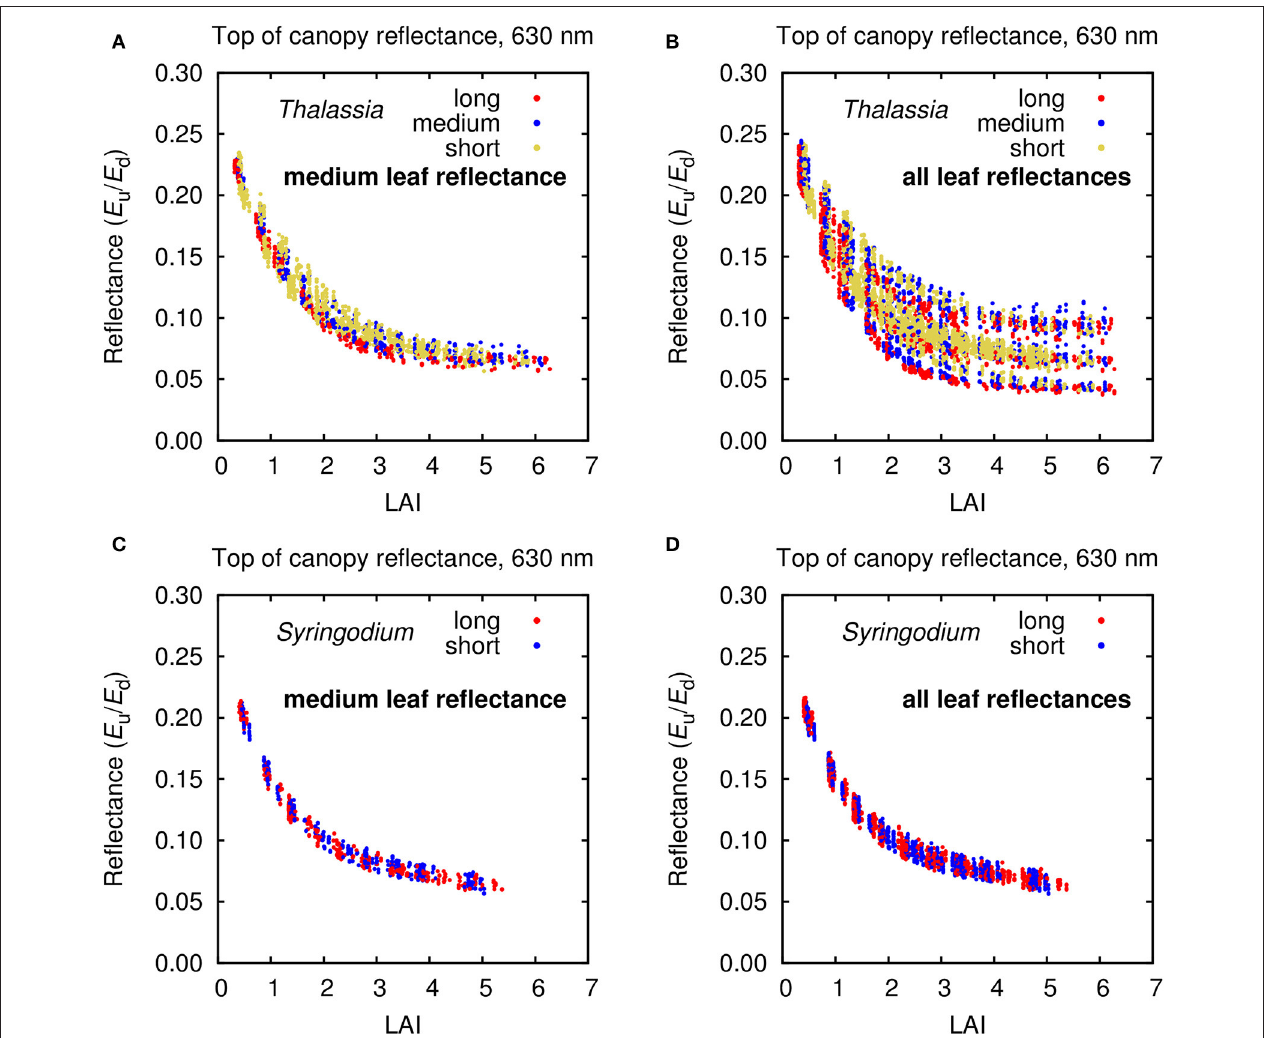
FIGURE 4 | Top of canopy (TOC) reflectance at 630nm for modeled (A,B) Thalassia and (C,D) Syringodium canopies under all treatments but differentiated by (A,C) medium leaf reflectances only and (B,D) all three leaf reflectance and absorptance treatments.